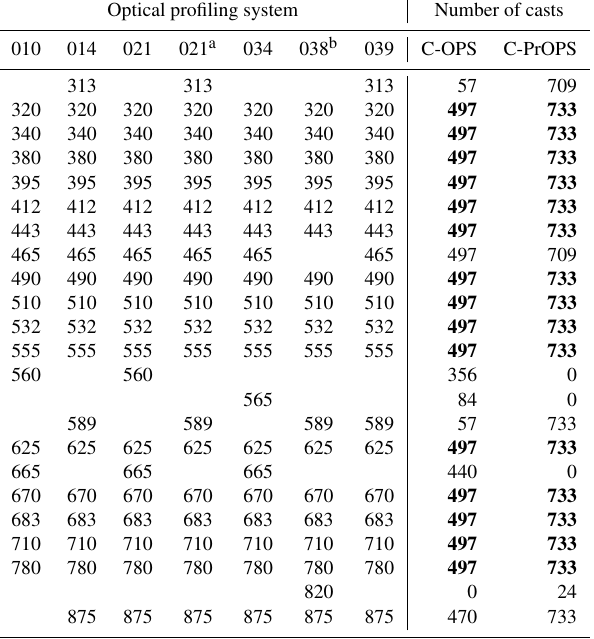
Figure 2. The geographical distribution of the original Canadian Arctic and US east coast data (open diamonds) used in Hooker